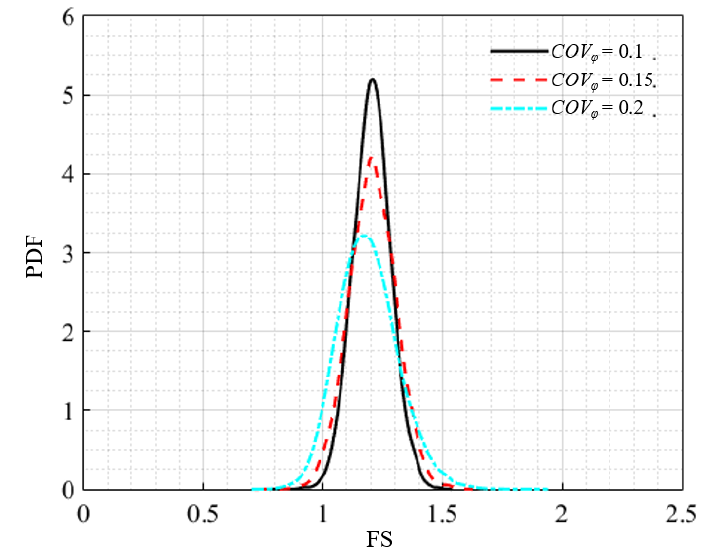
Figure 19. PDFs for different coefficients of variation.